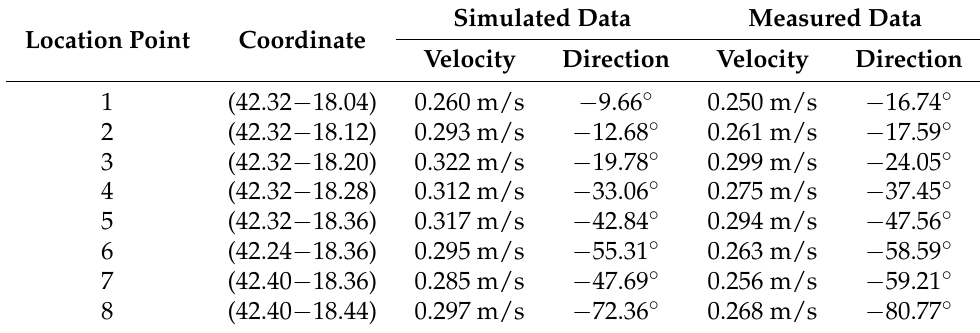
Table 2. Comparison between the simulated and measured current data.